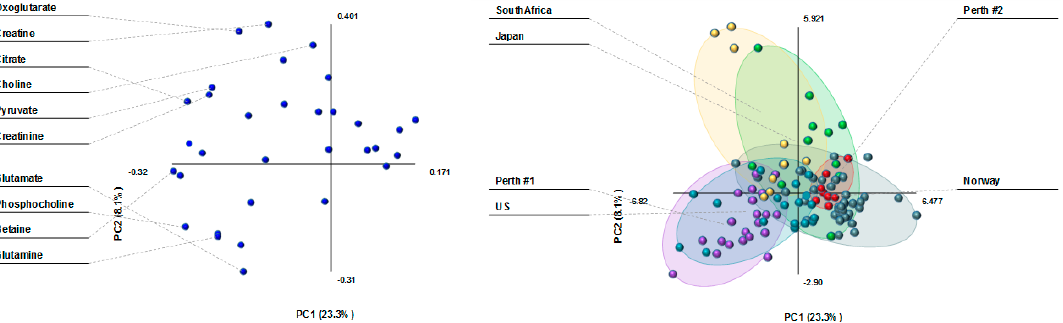
Figure 2. Partial Least Square Discriminant Analysis (PLS-DA) loading plot ( left ) and scatterplot ( right ) of human milk metabolites from 109 women in various countries. The score plot shows separation based on maternal country of origin (purple: Perth #1, atopic mothers; red: Perth #2, non-atopic mothers; green: Japan; aqua: US; dark green: Norway; and yellow: South Africa). The loading plot shows the milk metabolites that influence the separation based on maternal country of origin.